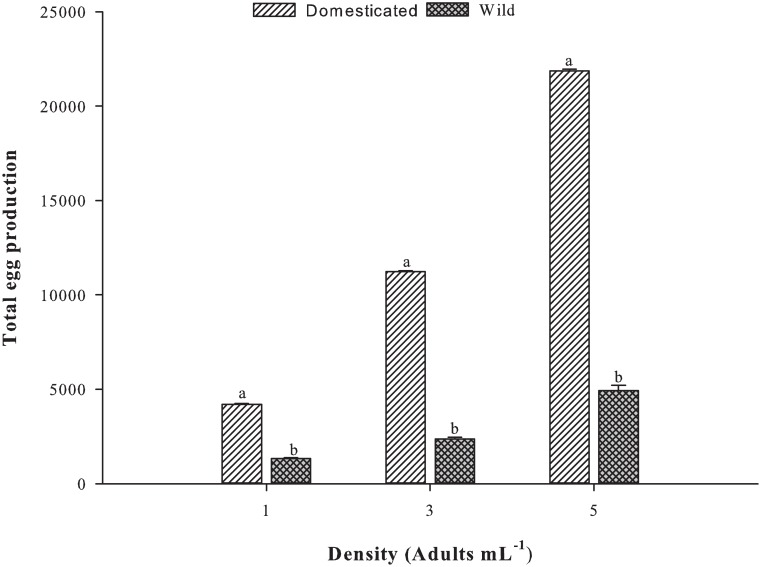
Mean total egg production of P. crassirostris strains under different initial adult stocking densities (n = 10).The different letters on the tops of the bars indicate significant differences (p <0.001).